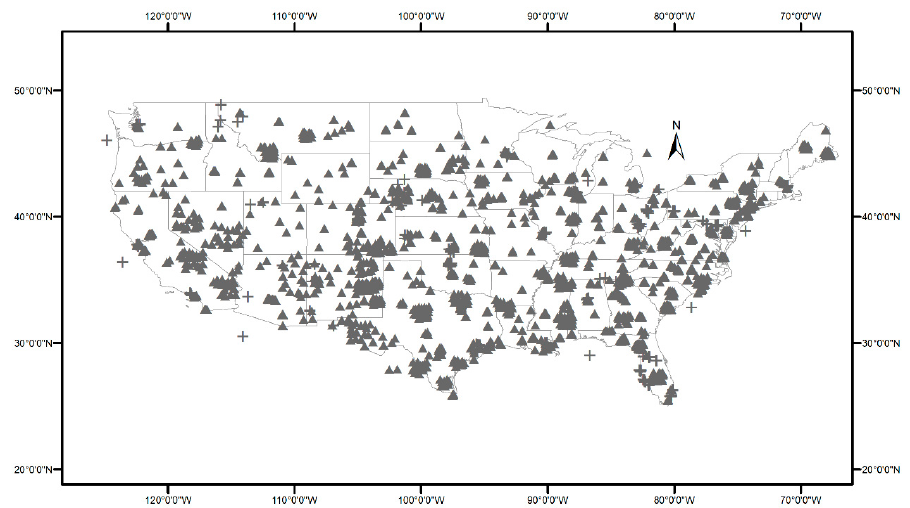
Figure 4. Urban and non-urban reference samples collected for the conterminous United States: (1) the cross “ + ” symbols indicate reference sample sites solely for training purposes, (2) the triangle “ ▲ ” symbols indicate reference sample sites solely for accuracy assessment. Sample sites of (1) and (2) were collected in two separate steps and are, therefore, totally